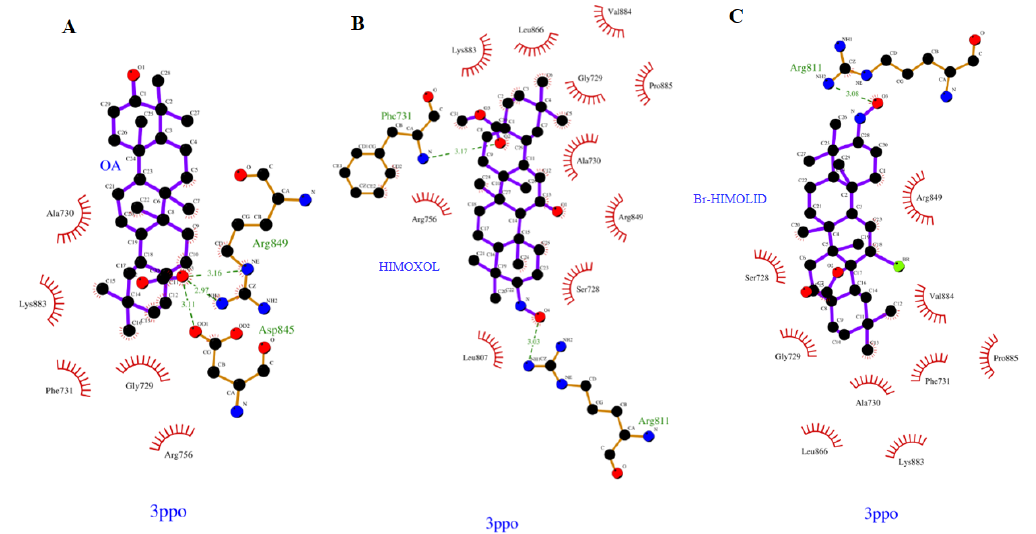
Figure 1. The first poses of the docked OA ( A ), HIMOXOL ( B ), and Br-HIMOLID ( C ) ligands with surroundings amino acids within the cavity (LigPlot+ v.2.2 software [22,23]).